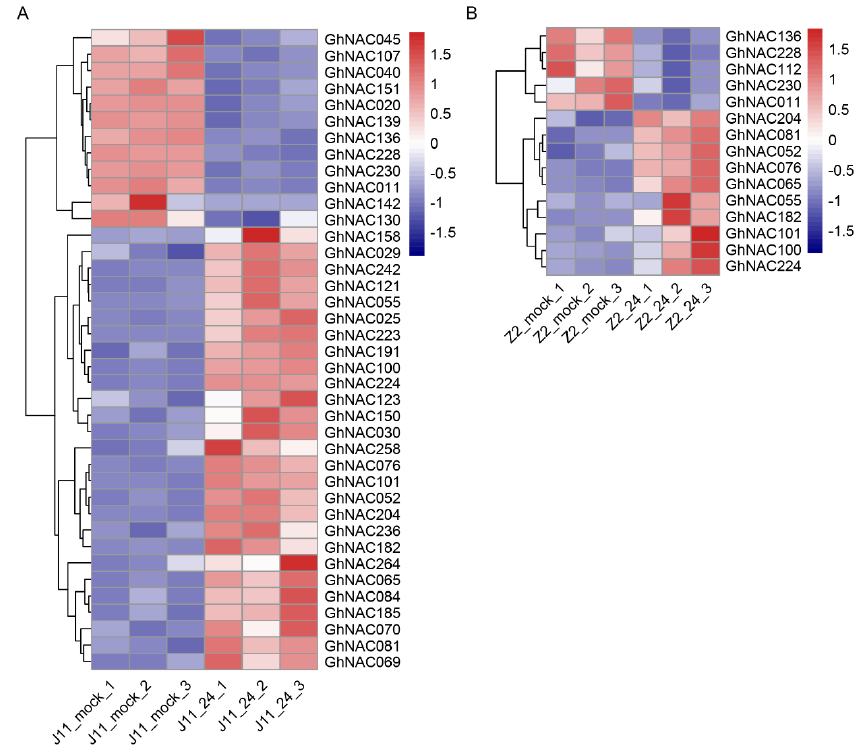
Figure 4. Expression profiling of GhNACs in response to V. dahliae stress. Hierarchical clustering of differentially expressed GhNACs in J11 ( A ) and Z2 ( B ). Red and blue colors show upregulation and downregulation, respectively. The original expression values of the GhNACs were normalized using Z-score. The signal intensity ranges from − 1.5 to 1.5, as the corresponding color also changes from blue to red.